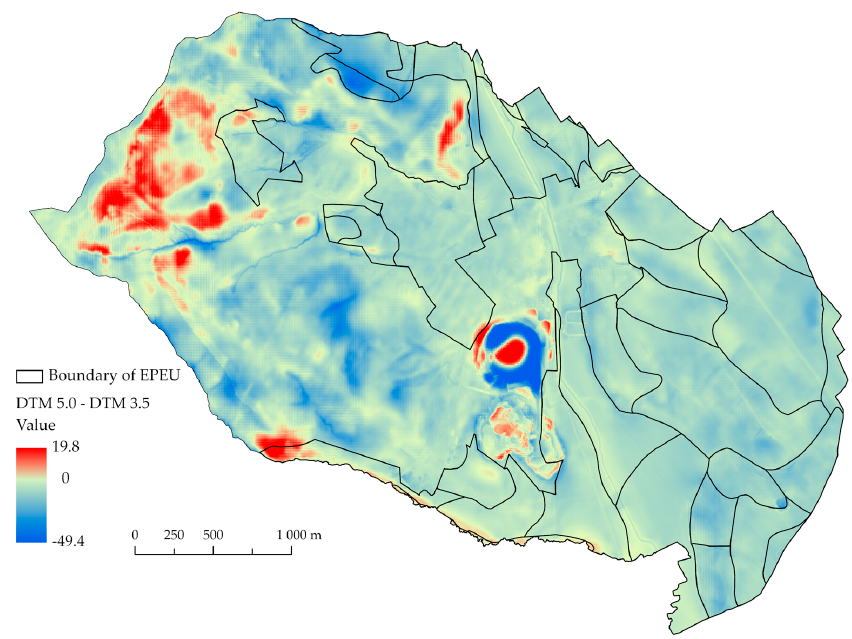
Figure 10. Comparison of height differences DTM 3.5 and 5.0.